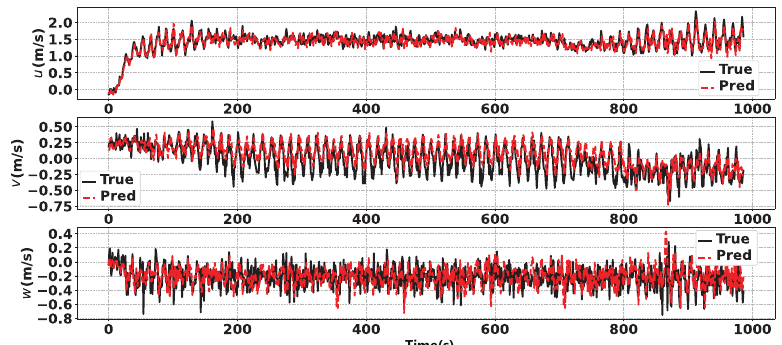
Figure 17. Identification result of AUV velocity.